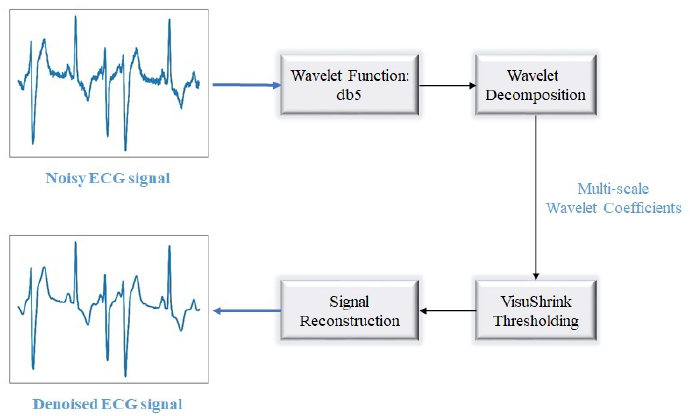
Figure 6. The denoising process of an ECG